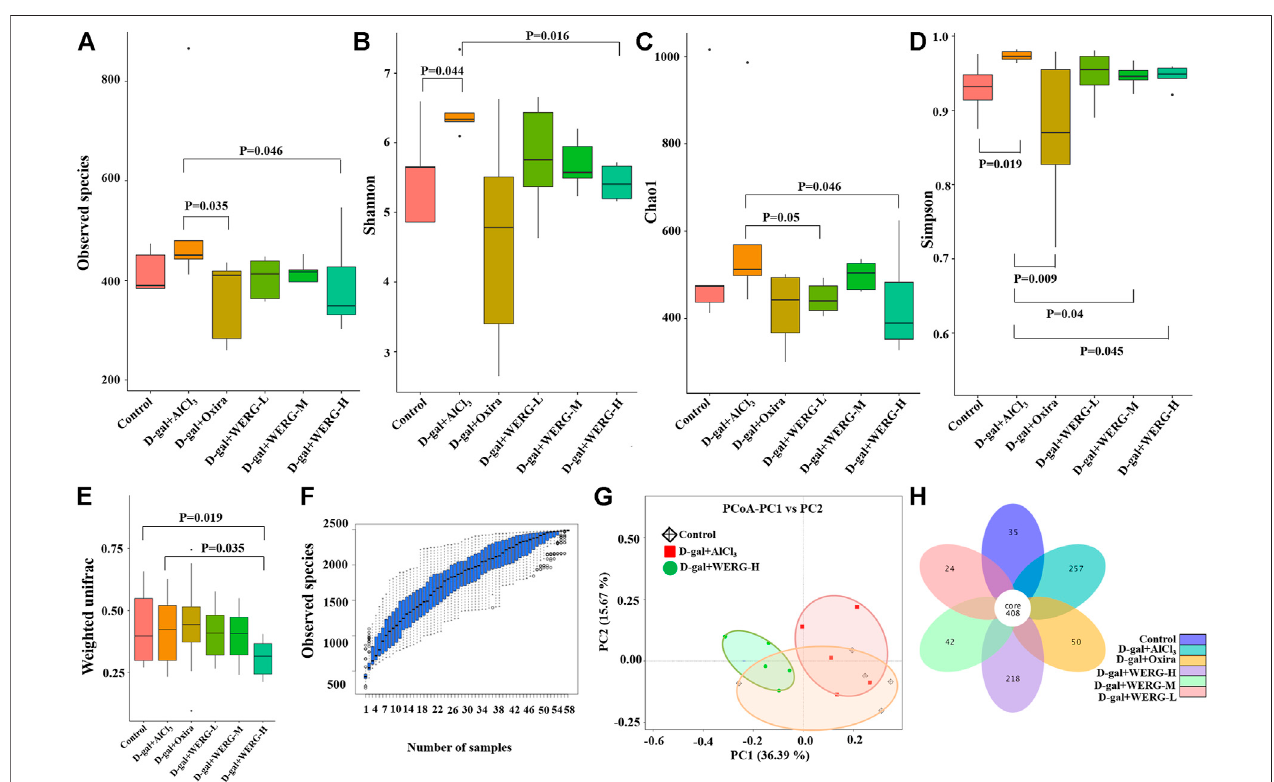
FIGURE 4 | Diversity and richness analysis of WERG-H on gut microbiota in D-gal/AlCl 3 -induced AD mice. The observed species number (A) ; Shannon diversity index (B) ; Chao1 diversity index (C) ; Simpson diversity index (D) ; weighted UniFrac analysis (E) ; the species accumulation curve (F) ; PCoA based on weighted UniFrac distances (G) ; fl ower diagrams (H) . n = 5 mice per